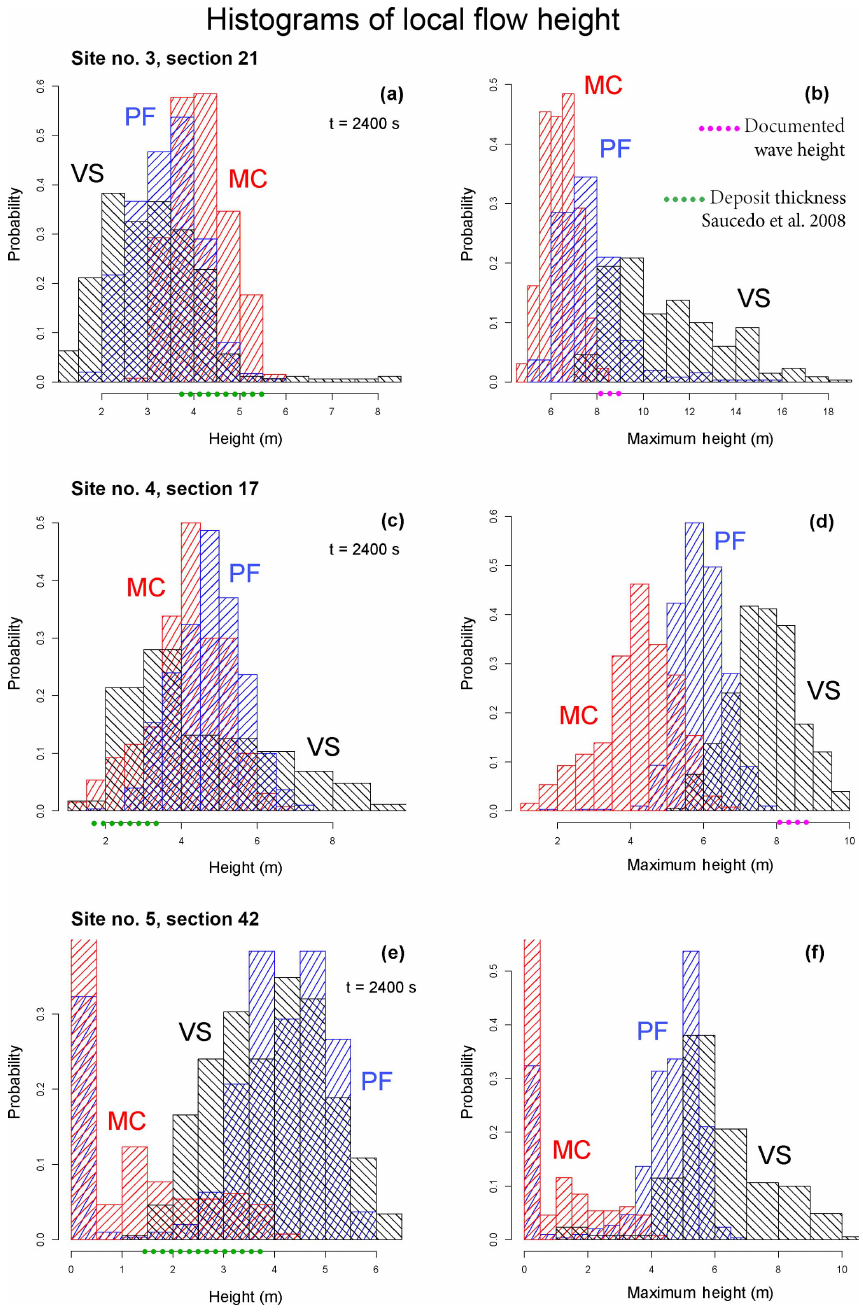
Figure 11. Histograms of local flow height in sites 3–5. Panels (a, c, e) show height at t = 2400s, while (b, d, f) show maximum height. Different models are displayed with different colors. Dots on the height axis show the uncertainty interval of data: green is the deposit thickness of Saucedo et al. (2008) and unpublished data; violet is the wave height documented by the survivors.